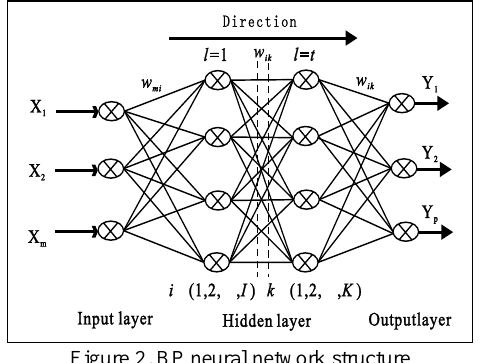
Figure 2. BP neural network